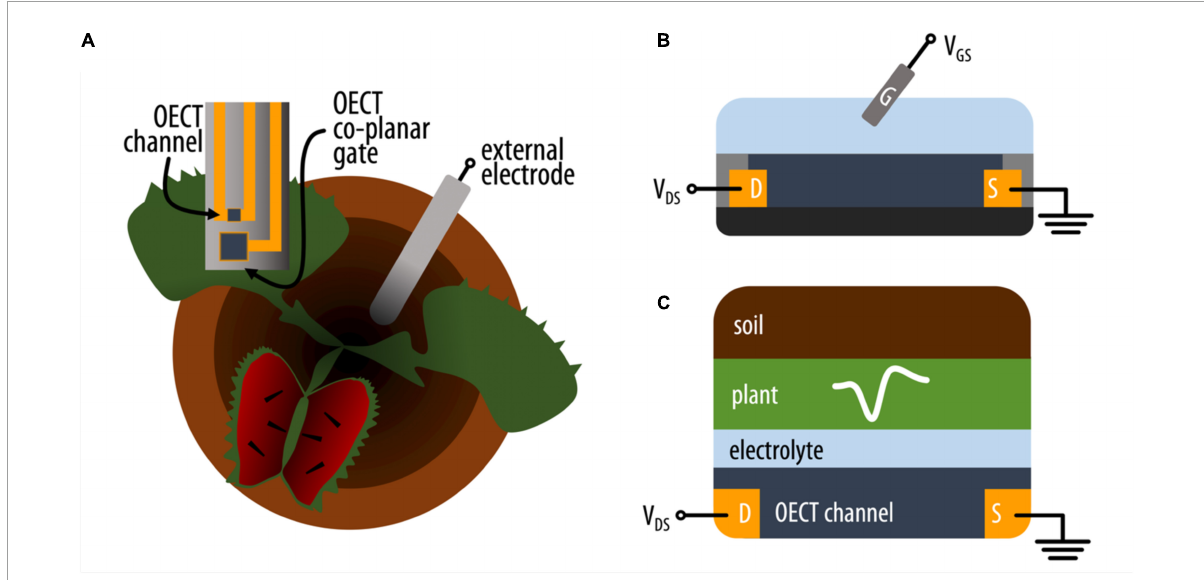
FIGURE1 (A) Schematic representation of the experimental setup where an OECT (top view) with channel and co-planar gate electrode is attached on the lobe of the VFT and an external electrode is placed in the soil. (B) Schematic (side) representation of an OECT where the current in the conducting polymer channel between source (S) and drain (D) electrodes is modulated by a voltage applied between the electrolyte and channel via a gate electrode (G). (C) Simplified schematic of the various electrolytic components interfacing with the OECT channel on the VFT lobe (side